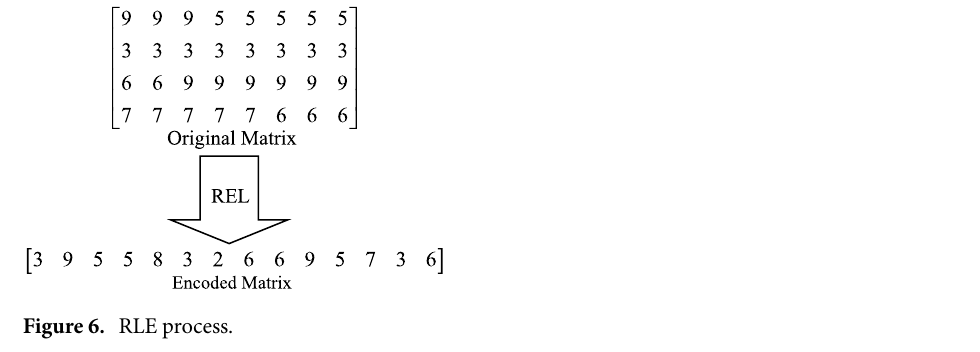
Differential Pulse Code Modulation (DPCM): DPCM is a kind of linear predictive coding and a lossy com- pression coding 44 . The main principle is: using the past sampling values to predict the current sampling values,